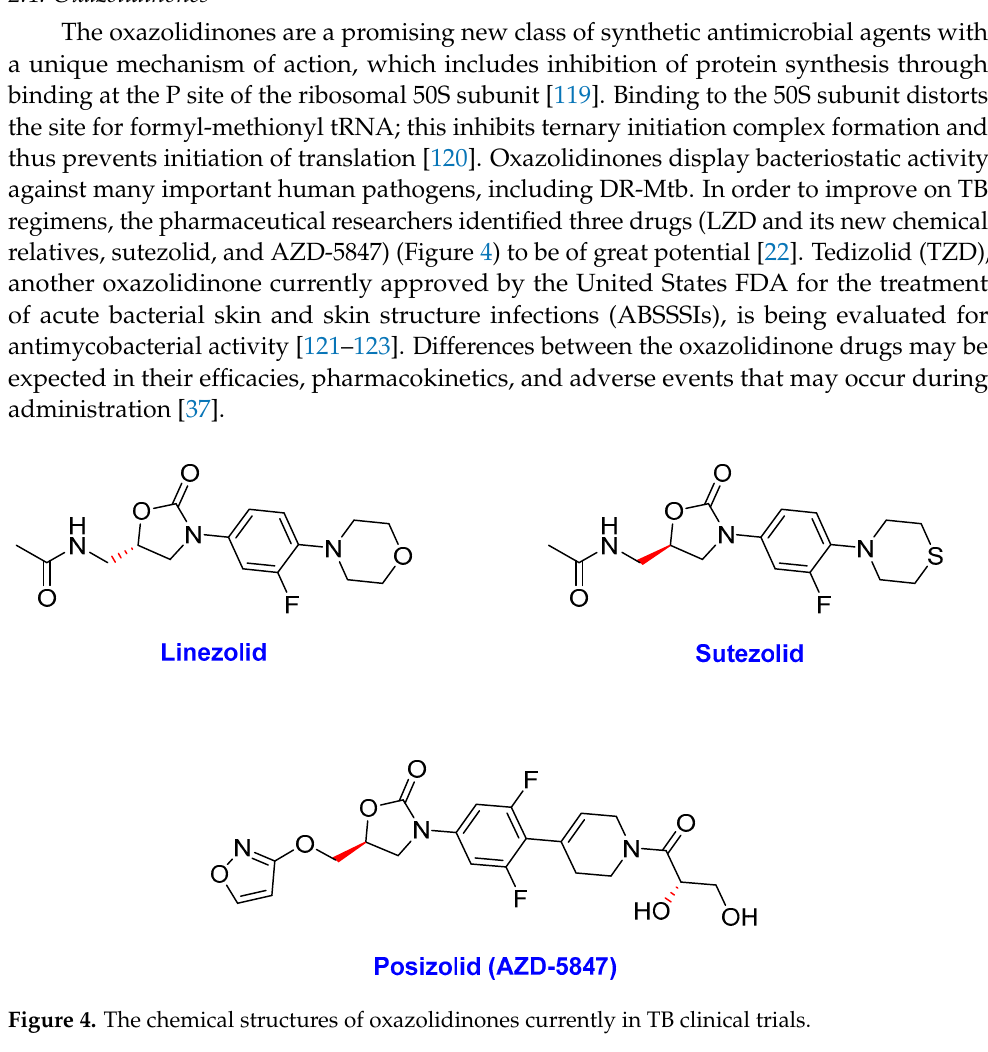
Figure 3. The chemical structure of nitroimidazoles undergoing clinical development as TB drugs.